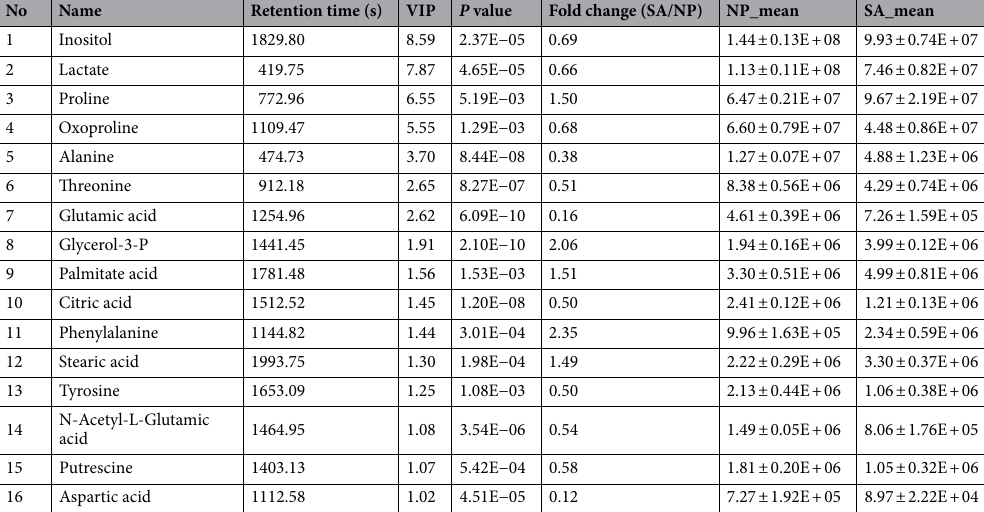
Table 1. Relative concentration of significantly changed metabolites in MDA-MB-231 cultured at pH 6.5 (mean ± SD).